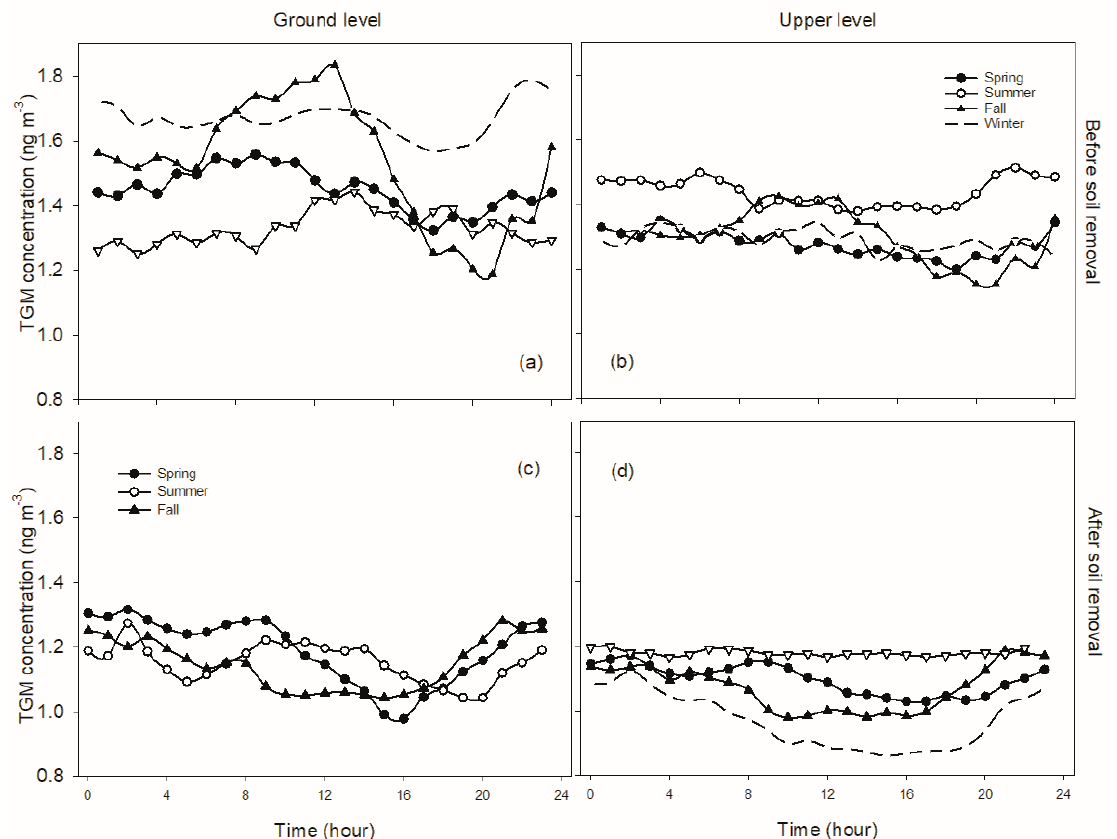
Figure 4. Comparison of diurnal patterns of TGM concentration at ground level ( a , c ) and height ( b , d ) before (2011–2012; ( a , b )) and after brownfield remediation (2015–2016; ( c , d )) at the Syracuse CoE.